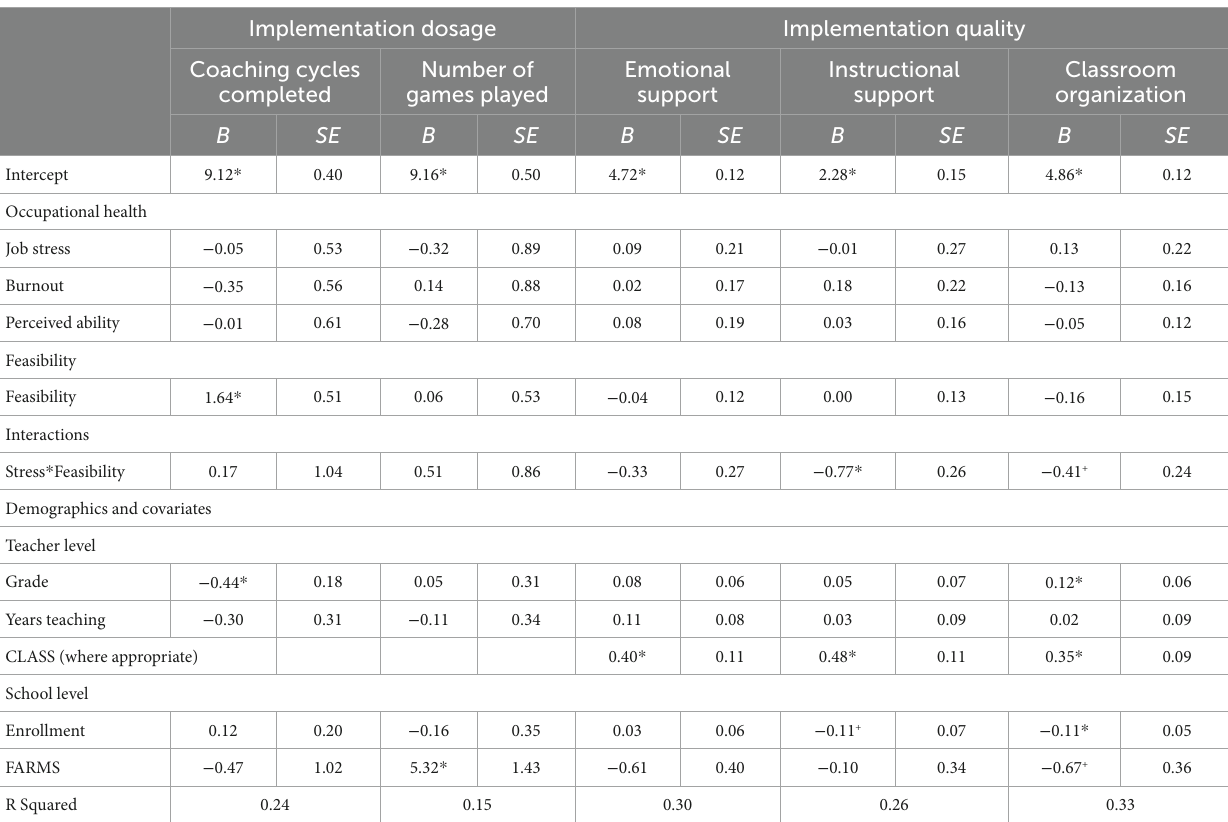
TABLE 4 Moderation models: predicting implementation dosage and quality of PAX GBG +